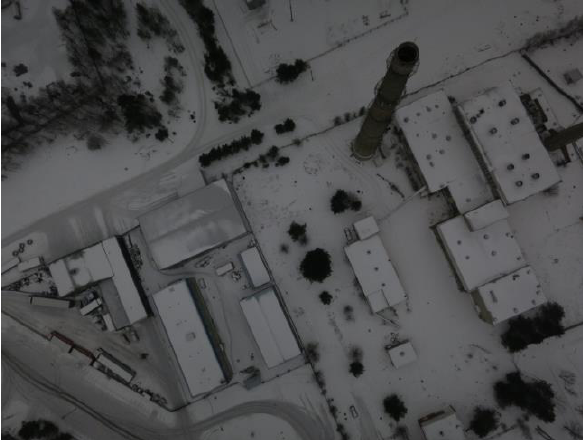
Figure 4. Image taken from altitude of 200 m